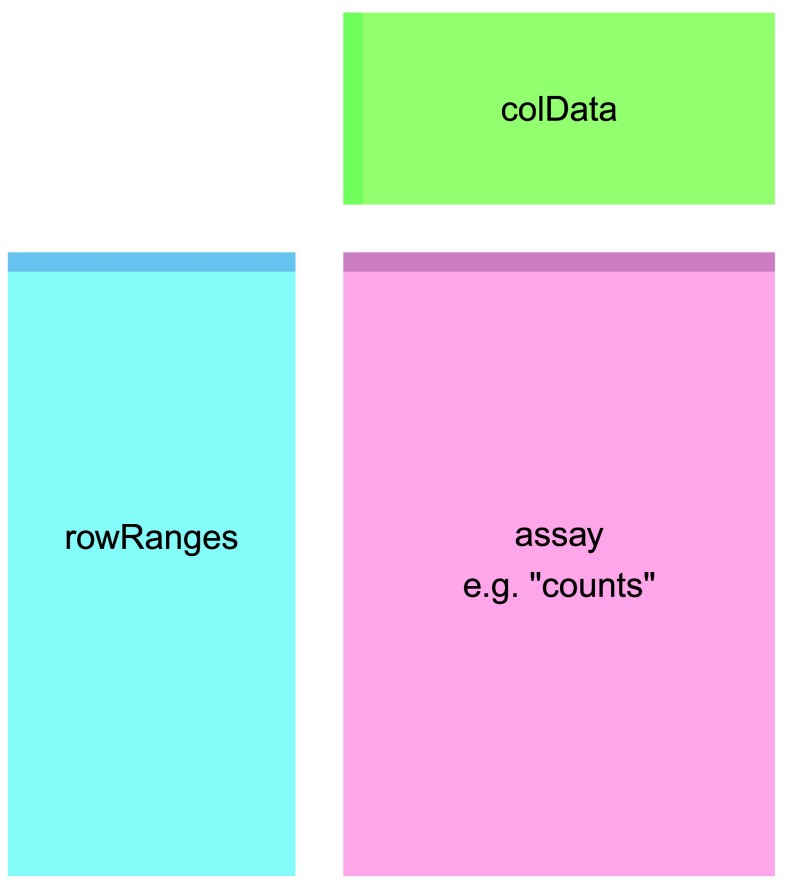
The component parts of a
SummarizedExperiment object.The
assay (pink block) contains the matrix of counts, the
rowRanges (blue block) contains information about the genomic ranges and the
colData (green block) contains information about the samples. The highlighted line in each block represents the first row (note that the first row of
colData lines up with the first column of the
assay).